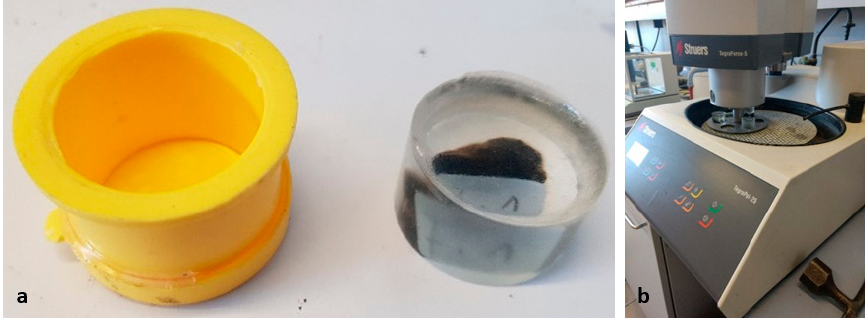
Figure 3. Plastic mold for preparation of the stone-resin samples ( a ) and the polishing machine ( b ).